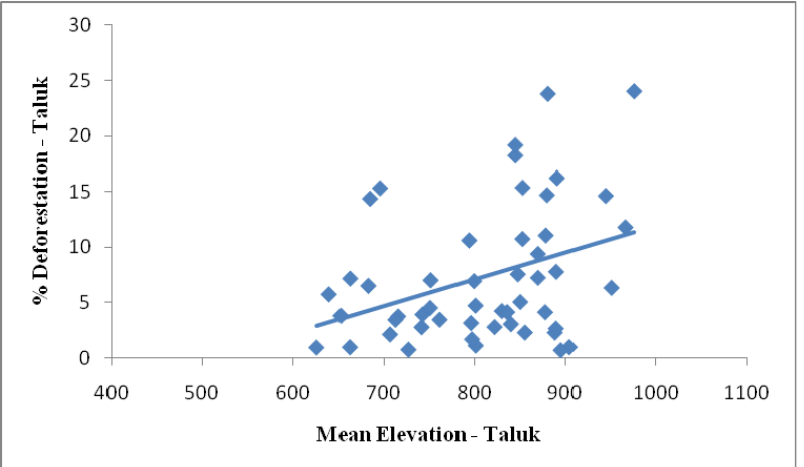
Figure 9b. Relationship between mean elevation and the distribution of deforestation for taluks.